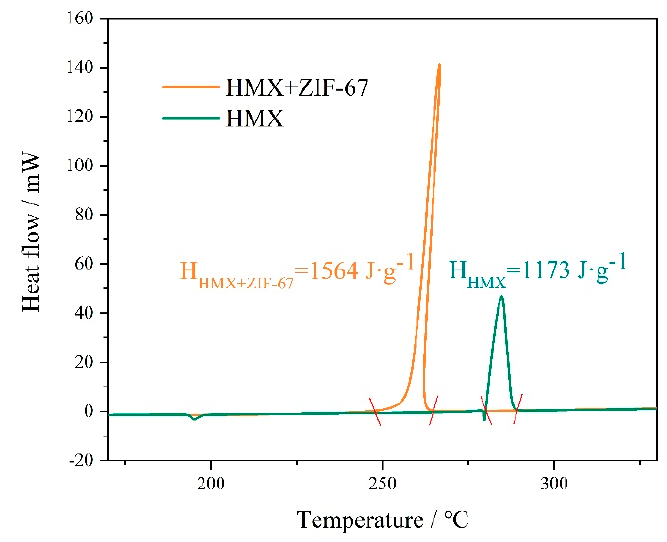
Figure 7. The heat release of HMX and HMX+ZIF-67. The MS spectrogram for the products of HMXand HMX+ZIF-67 is shown in Figure 8. It can be seen from the mass spectra of HMX and HMX+ZIF-67 that the amount of fragments ( m / z = 30 and m / z = 44) in both were the largest. A small amount of fragments of m / z = 30 were first detected in the MS of HMX and HMX+ZIF-67 at 277 ◦ C or 235 ◦ C, which indicates that a small amount of nitro and nitroso were transformed into each other in the process of the denitrication of HMX, and a small amount of NO ( m / z = 30) was first decomposed and released [23,24]. A large number of m / z = 30 fragments in the mass spectrogram of HMX began to be produced at 280 ◦ C. At the same time, a large amount of m / z = 44 fragments began to be released. The analysis shows that the substance corresponding to m / z = 30 should be mainly CH 2 O and the fragment corresponding to m / z = 44 is N 2 O, because the C-N bond on the HMX ring and the N-O bond in the nitro group begin to break at this time. In addition, we also found that a small number of fragments with m / z = 27 and m / z = 46 were formed at this time. It can be seen from the literature [25] that the thermal decomposition mechanism of HMX is that N-NO 2 and C-N bond breaks at the same time. Therefore, the material fragments corresponding to m / z = 27 and m / z = 46 should be considered to be HCN and NO 2 ,